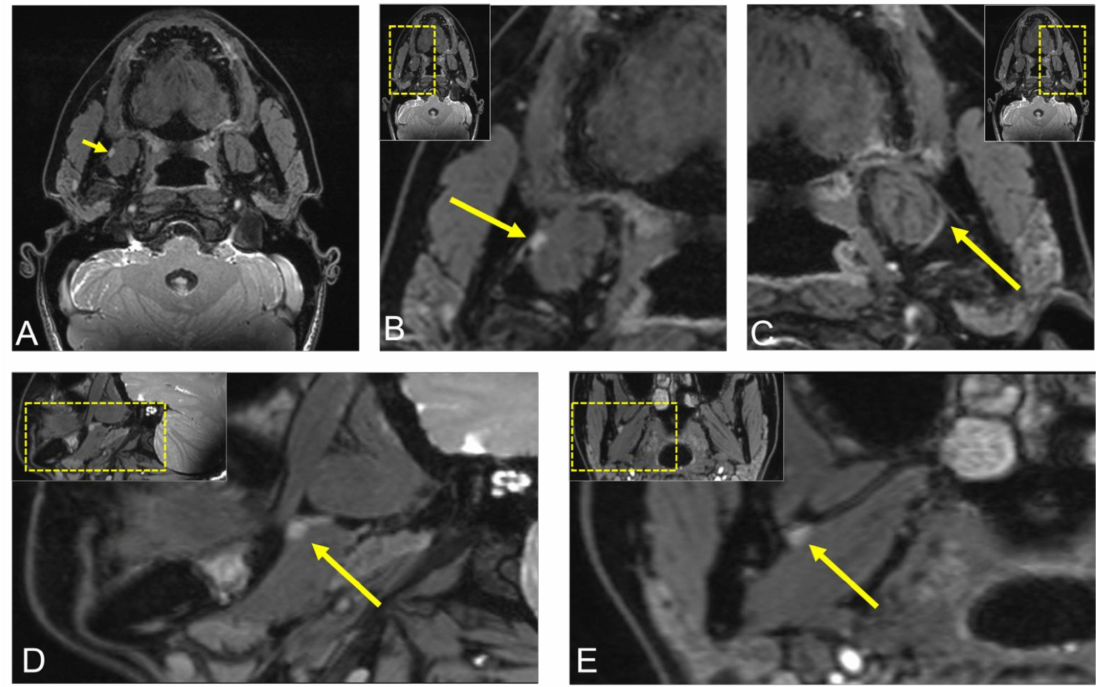
Figure 4. Postoperative visualization of the lingual nerve (LN) using 3D double-echo steady-state (3D-DESS) MRI in the same patient. ( A , B ) Axial, ( D ) sagittal, ( E ) coronal reconstruction of the region of interest displaying the LN asymmetry throughout its course through the infratemporal fossa, with an LN hyperintense nodular lesion of 5 × 3 mm between the right medial pterygoid muscle and the mandible. ( C ) Axial image reconstruction of the healthy LN on the contralateral side for comparison. For orientation, the dotted rectangles in the corner show the enlarged